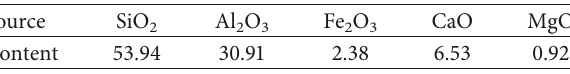
Table 2: Chemical composition of fly ash (%).